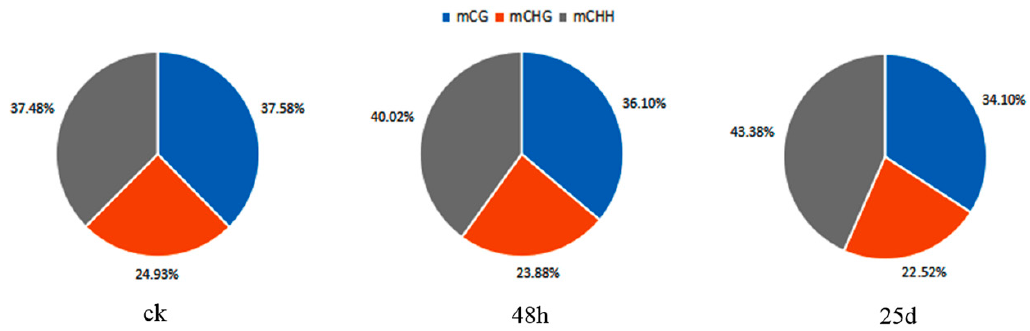
Figure 3. Percentages of methylated cytosines in each sample of watermelon leaves under each context.